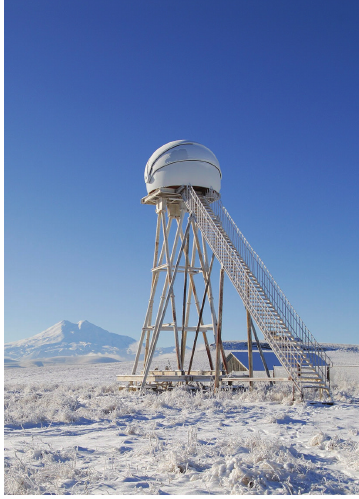
Figure 7: MASTER II (Kislovodsk, Sternberg Astronomical Insti- tute, Moscow State University). Photo by A. Belinskiy.